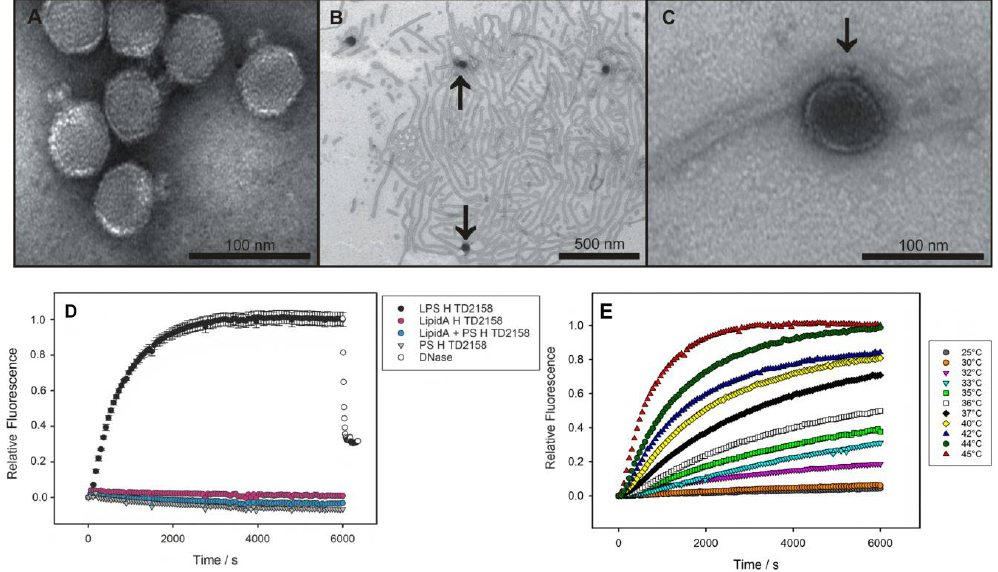
Figure 1. LPS-mediated DNA-release from phage HK620 observed in vitro. ( A ) Transmission electron microscopy images of phage HK620 particles (1 × 10 10 pfu mL −1 ) stained with 1% ( w / v ) uranyl